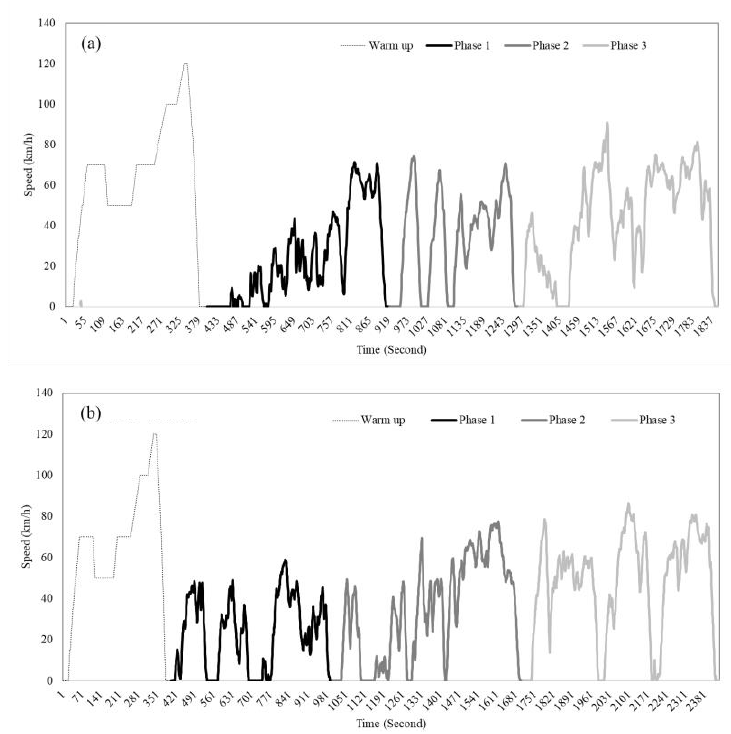
Figure 2. The Bangkok driving cycle for ( a ) LDG and ( b ) LDD vehicles.